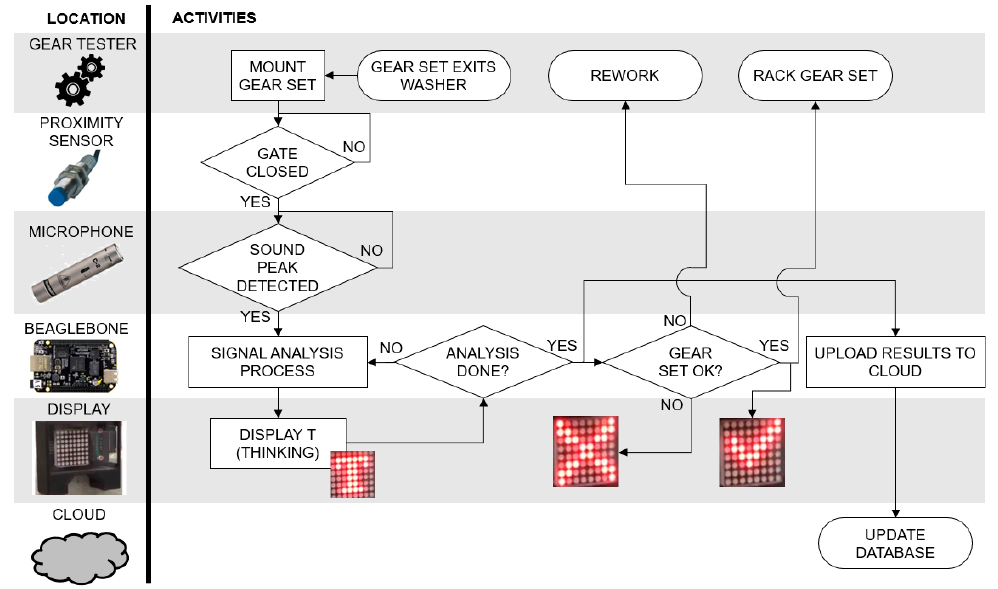
Figure 6. General view of the gear noise test system’s architecture and operation. The gears go through a washing process prior to the noise test, which starts when the gears are mounted.